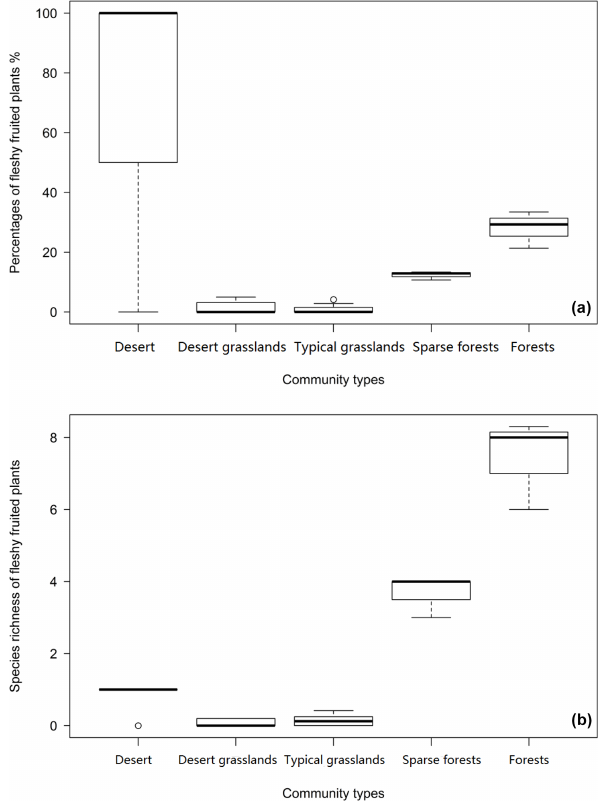
Figure 4. Proportions (a) and species richness (b) of plants with fleshy fruits decline gradually from forests through sparse forests to (typical and desert) grasslands but increase in deserts (the same letter indicates difference is insignificant at p > 0 .